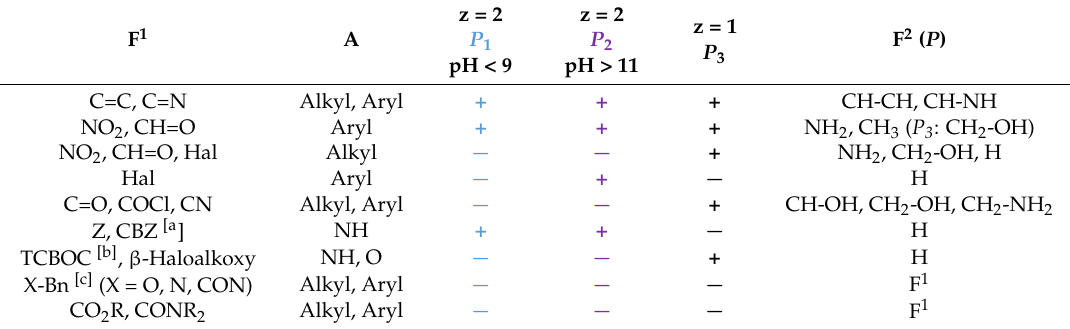
Table 2. Catalysis-pattern P i (i = 1–3) of the catalyst Pd Z Pc transforming A-F 1 to A-F 2 referred to